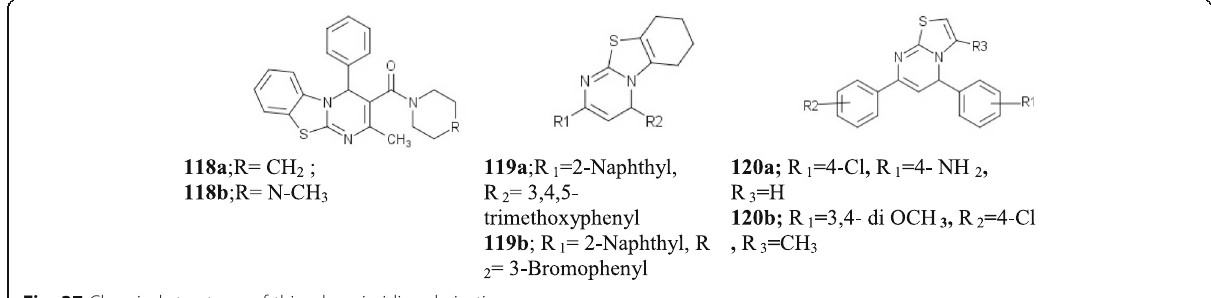
Fig. 37 Chemical structures of thiazolopyrimidine derivatives